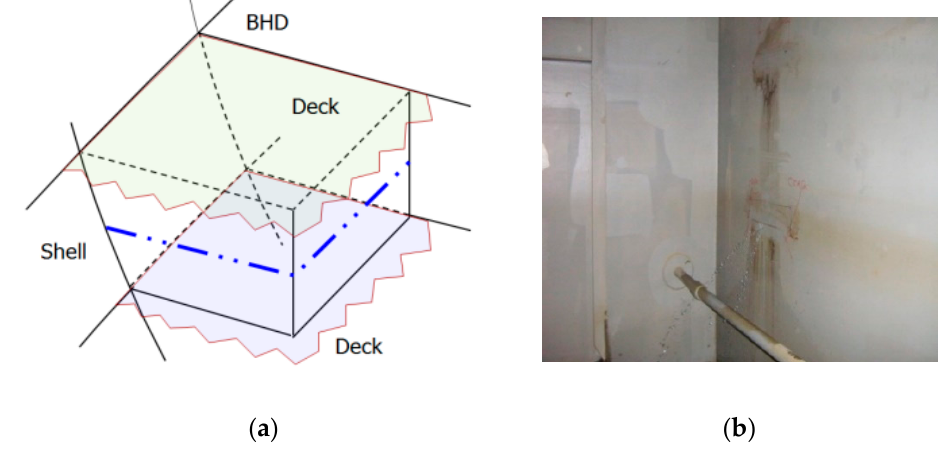
Figure 1. Arrangement of fresh water and fuel tanks in ship: ( a ) the arrangement shape of the tank; ( b ) 1700 TEU Container fresh water tank wall damage.